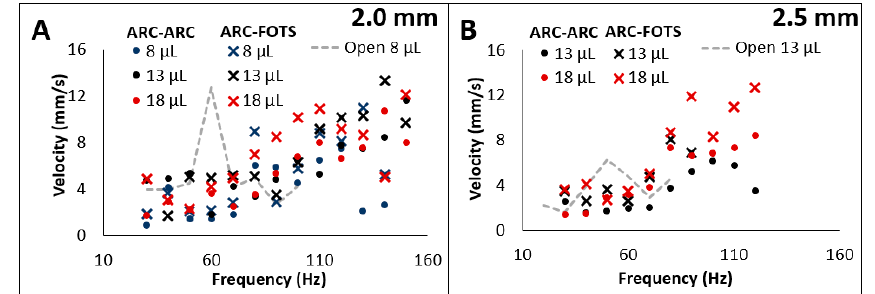
Figure 5. Transport velocity is correlated with vibration frequency on a two-plate system. Transport velocity at the anisotropic ratchet conveyor (ARC) threshold trends upward with increasing frequency on two-plate systems with ( A ) 2.0 mm and ( B ) 2.5 mm separations. Gray dashed lines indicate the velocity profiles of (A) 8 µL and (B) 13 µL droplets on open ARC systems with the same pattern. The velocity profiles on open systems are characterized by a peak velocity related to the droplet volume and a sharp drop in velocity at higher frequencies, whereas velocity profiles on the enclosed system generally increase with vibration frequency although volume dependent local maxima and minima are observed.